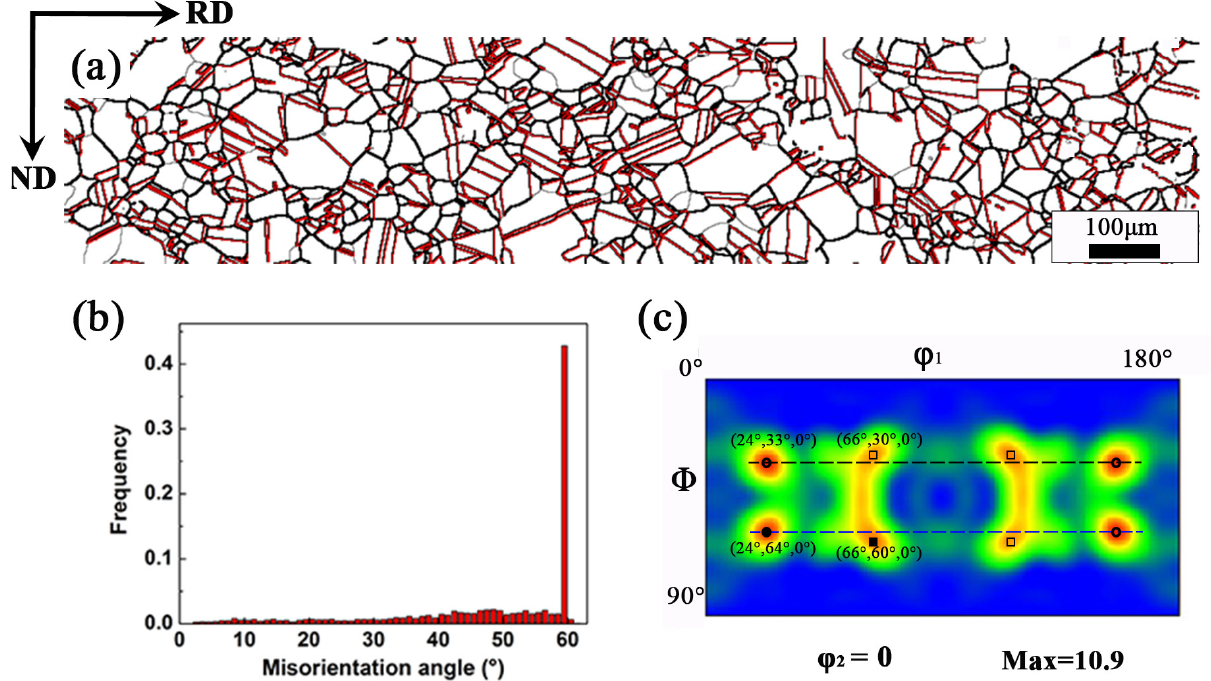
Figure 7: (a) Grain boundary map showing microstructure, (b) misorientation distribution map and (c) φ 2 = 0 ∘ section ODF of the sample annealed at high temperature of 800 ∘ C for 20